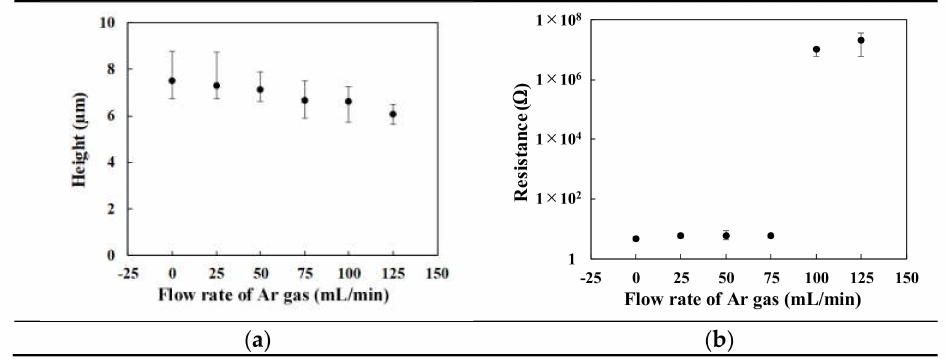
Figure 8. ( a ) Height and ( b ) resistance of the patterns fabricated under various injection rate of Ar